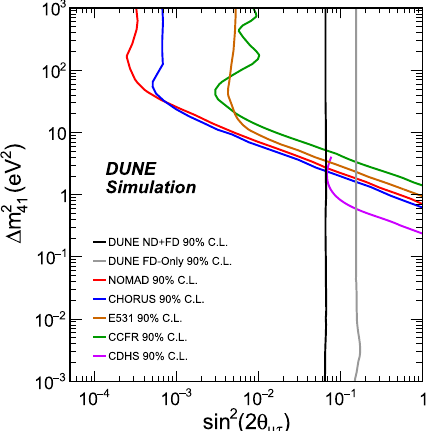
Fig. 3 Comparison of the DUNE sensitivity to θ 34 using the NC sam- ples at the ND and FD with previous and existing experiments. Regions to the right of the contour are excluded